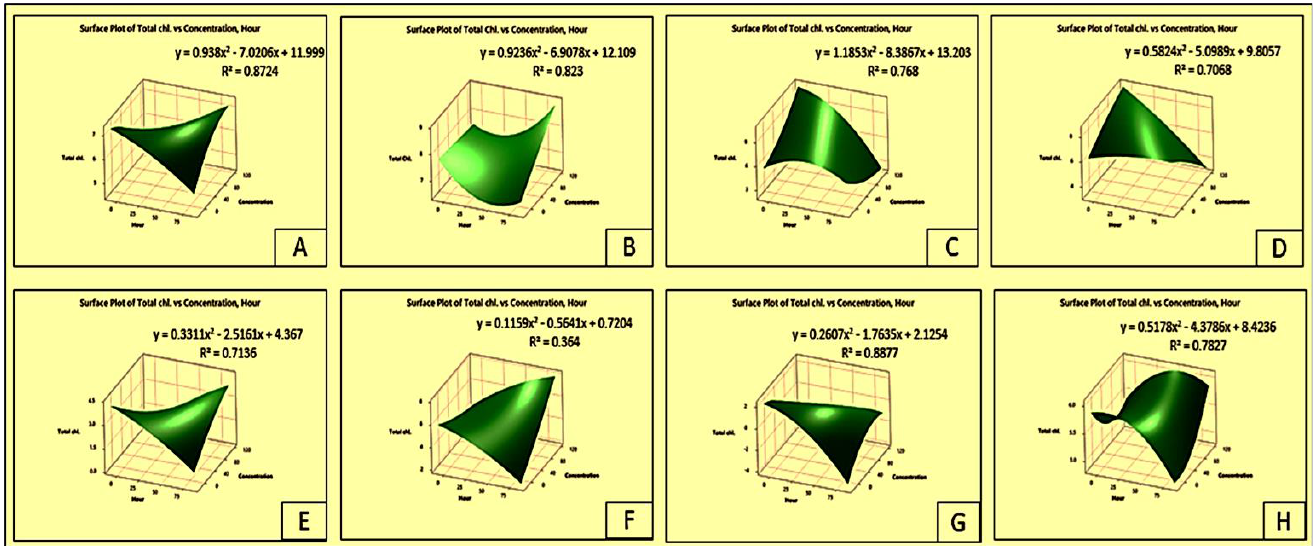
Figure 6. Surface plot of total chlorophyll vs. concentration hours as a consequence of parthenium leaf methanol extract on several crops and weeds: ( A ) -Bambara groundnut; ( B ) -Maize; ( C ) - D. san- guinalis ; ( D ) - E. indica ; ( E ) - A. conyzoides ; ( F ) - C. iria ; ( G ) - E. hirta , and ( H ) - C. difformis . ( C )— D. sanguinalis ; ( D )— E. indica ; ( E )— A. conyzoides ; ( F )— C. iria ; ( G )— E. hirta , and ( H )— C. difformis